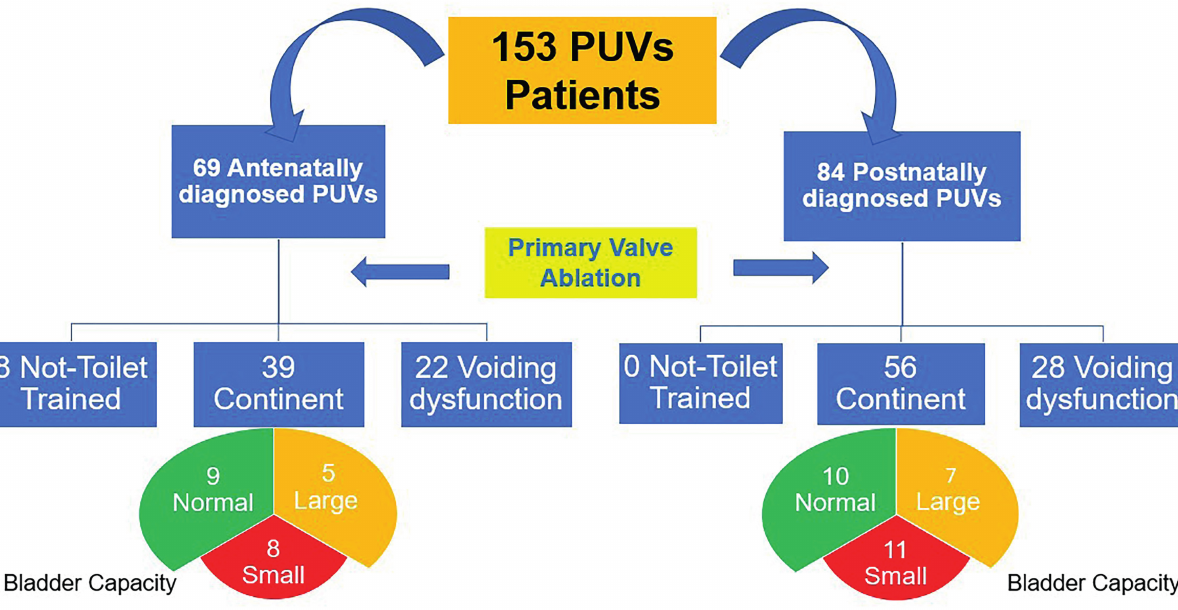
Figure 1 - Flow chart of our study groups with bladder function and bladder capacity